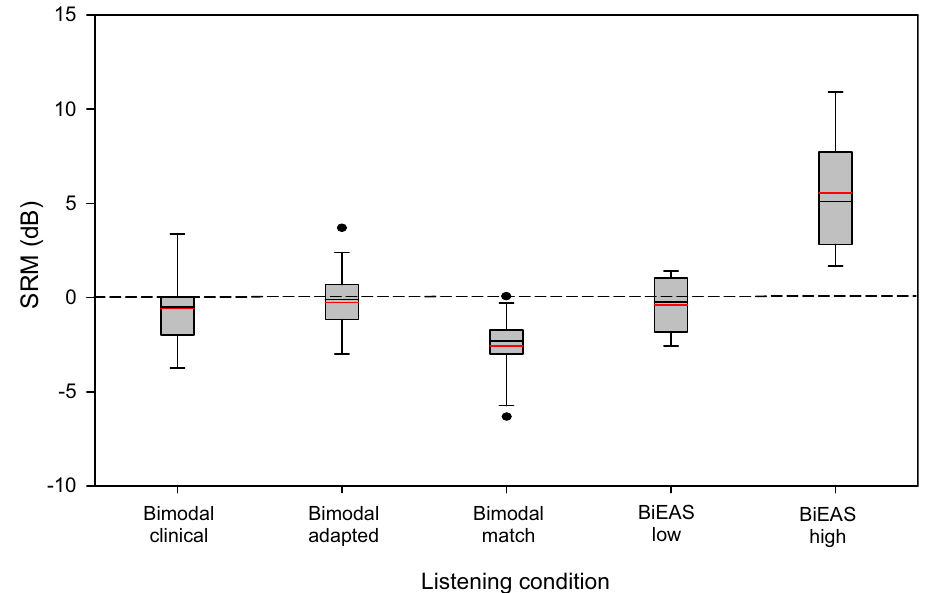
Table 2. Negative mean SRM (i.e., poorer performance with spatially separated than with co-located maskers) was observed for all listening conditions except for the BiEAS high condition. An RM ANOVA performed on the SRM data showed a significant effect for listening condition [F(4,44) = 27.2, p < 0.001]. Post-hoc Bonferroni pairwise comparisons showed that SRM was significantly higher (better) for the BiEAS high condition than for the other conditions (p < 0.01), and significantly higher for the BiEAS low condition than for the Bimodal match condition (p < 0.05).